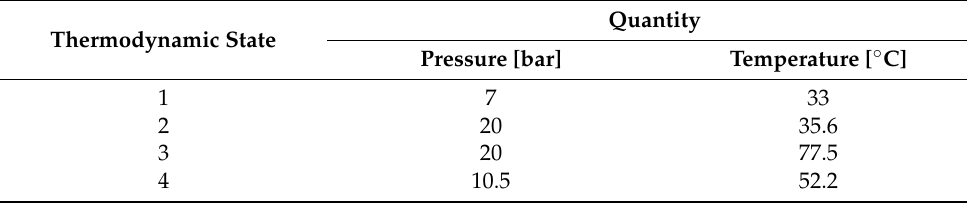
Table 5. Thermodynamic states of the Organic Rankine Cycle (ORC) under examination. Thermodynamic